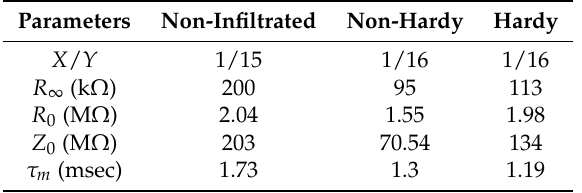
Table 2. Parameters of the Scots Pine needle equivalent model of Figure 4